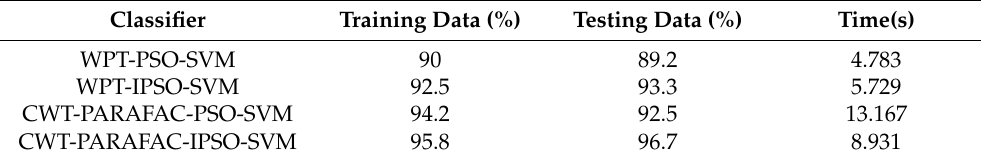
Table 6. Correction rate of four classifiers with single-channel data analysis.